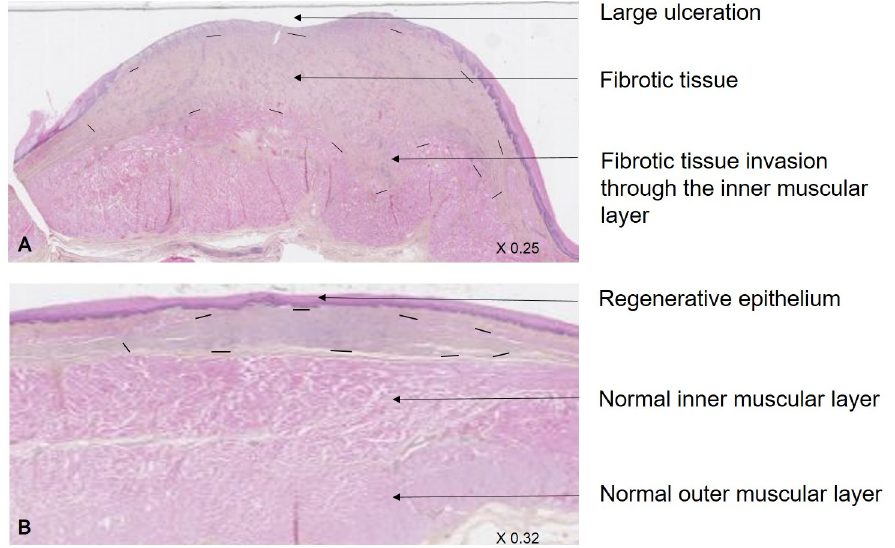
Fig 5. Histological assessment. HES labelled esophagus slides centered on stricture area, obtained after digitalization and read using NDP.view software (magnification x0.25 and x0.32). In control group (A), there was an intense development of fibrosis (delimited by dotted line), with a systematical large destruction of the muscularis mucosae, an invasion of the inner muscularis layer and a high re-epithelialization defect. Comparatively, in the ADSC group, healing process was improved with an increased scar re-epithelialization and a decreased fibrosis development, always respecting the inner muscularis